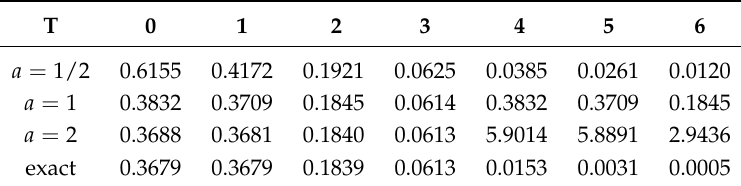
Table 6. Order 4 CIR method approximation of the Poisson(1)